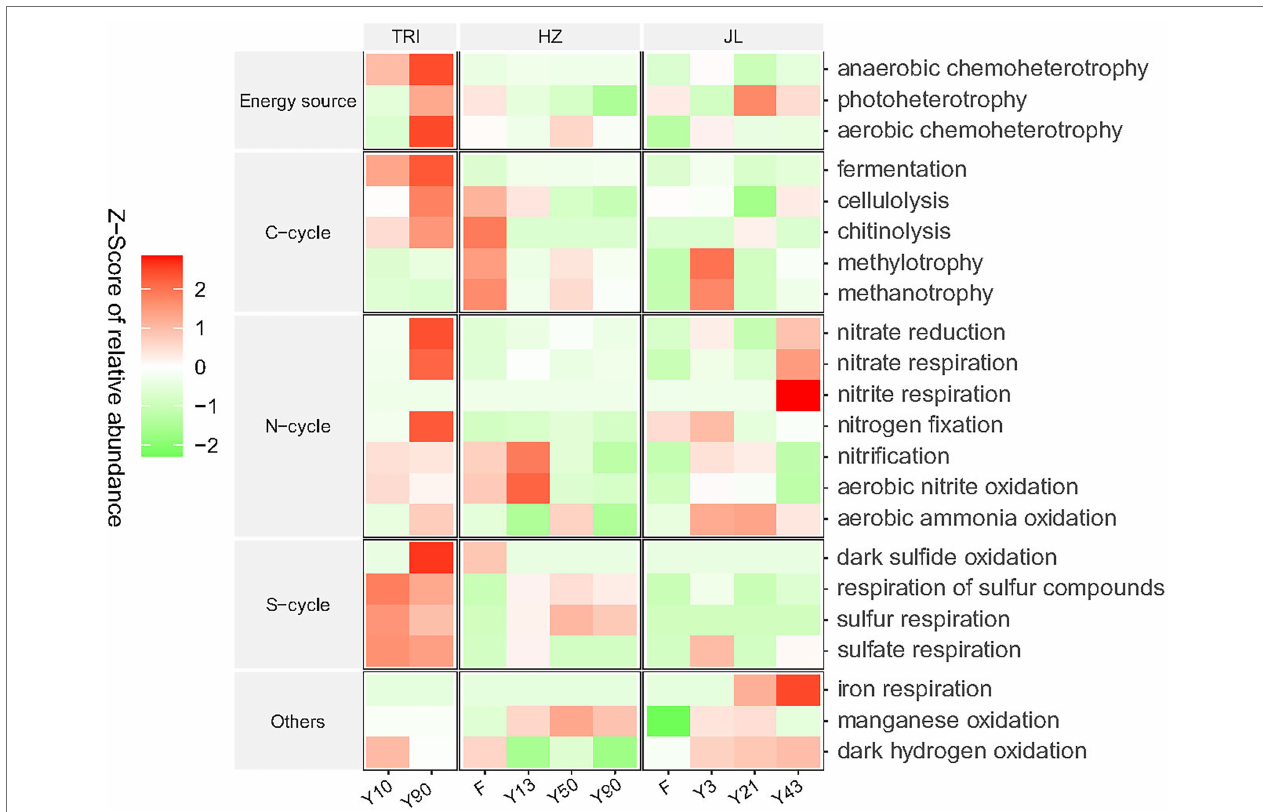
FIGURE 4 | Function predictions of microbial communities in tea plantation soils across varying stand ages and different sampling sites by FAPROTAX. The relative abundance of each functional category is normalized and represented by a